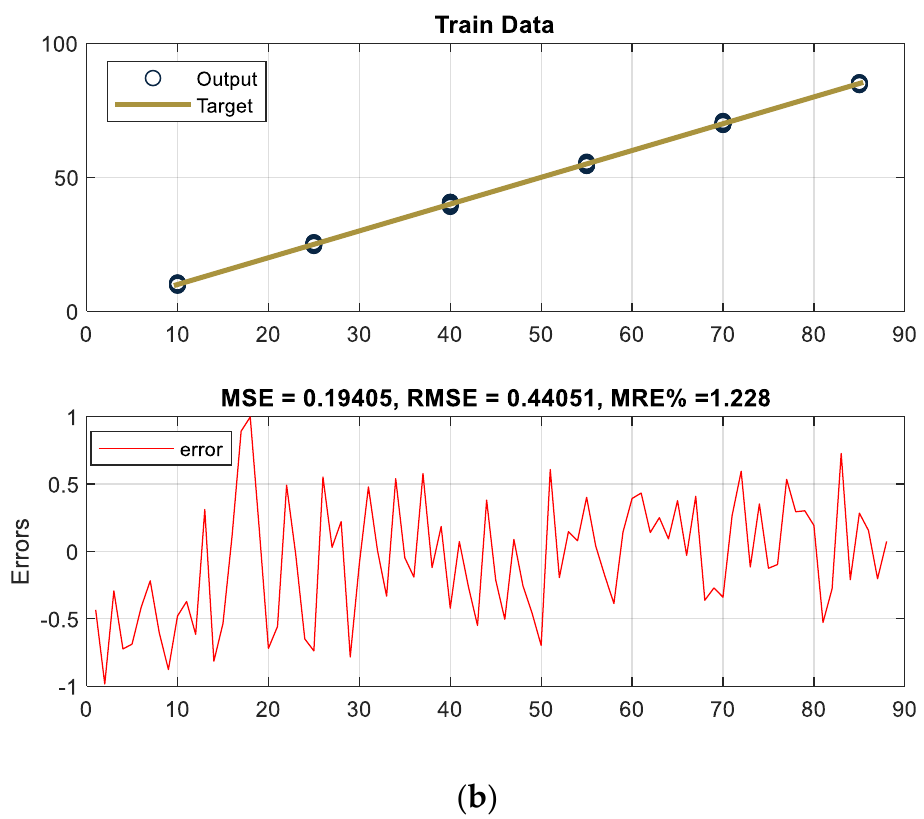
Figure 7. Designed network performance against ( a ) training and ( b ) testing data.